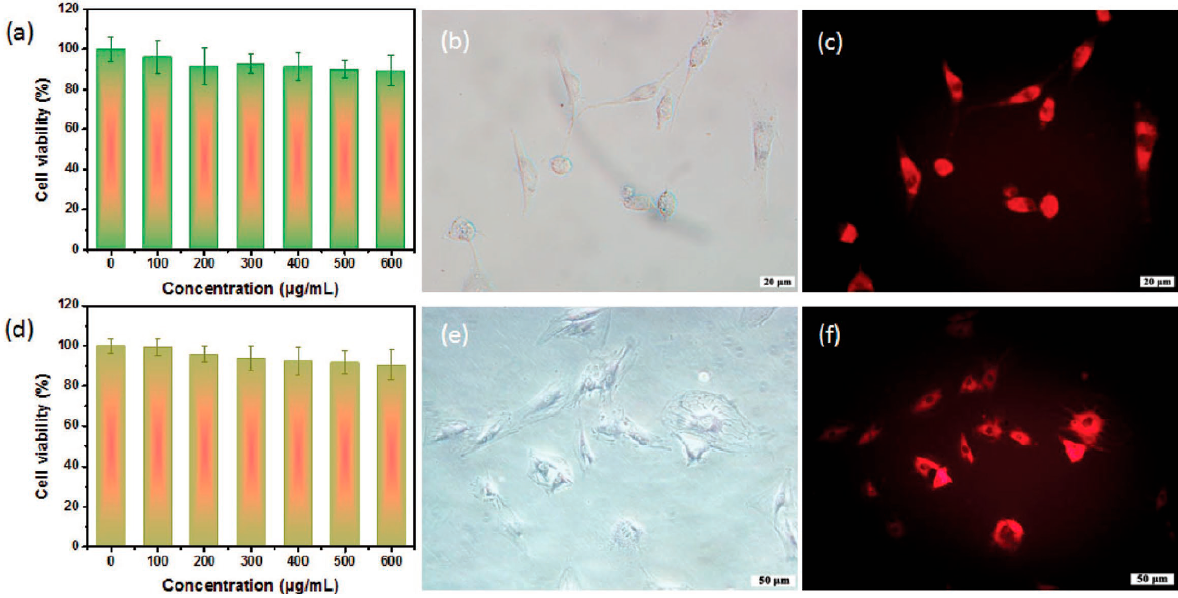
Figure 7. Viability of MC3T3-E1 ( a ) and BMSCs cells ( d ) after incubation with C-dots for a 24 h uptake process. FL images of ( b , c ) MC3T3-E1 and ( e , f ) BMSCs, respectively; ( b , e ) bright field and ( e , f ) under λ ex = 530 nm. Reprinted (adapted) with permission from [72]. Copyright 2021 John Wiley and Sons.